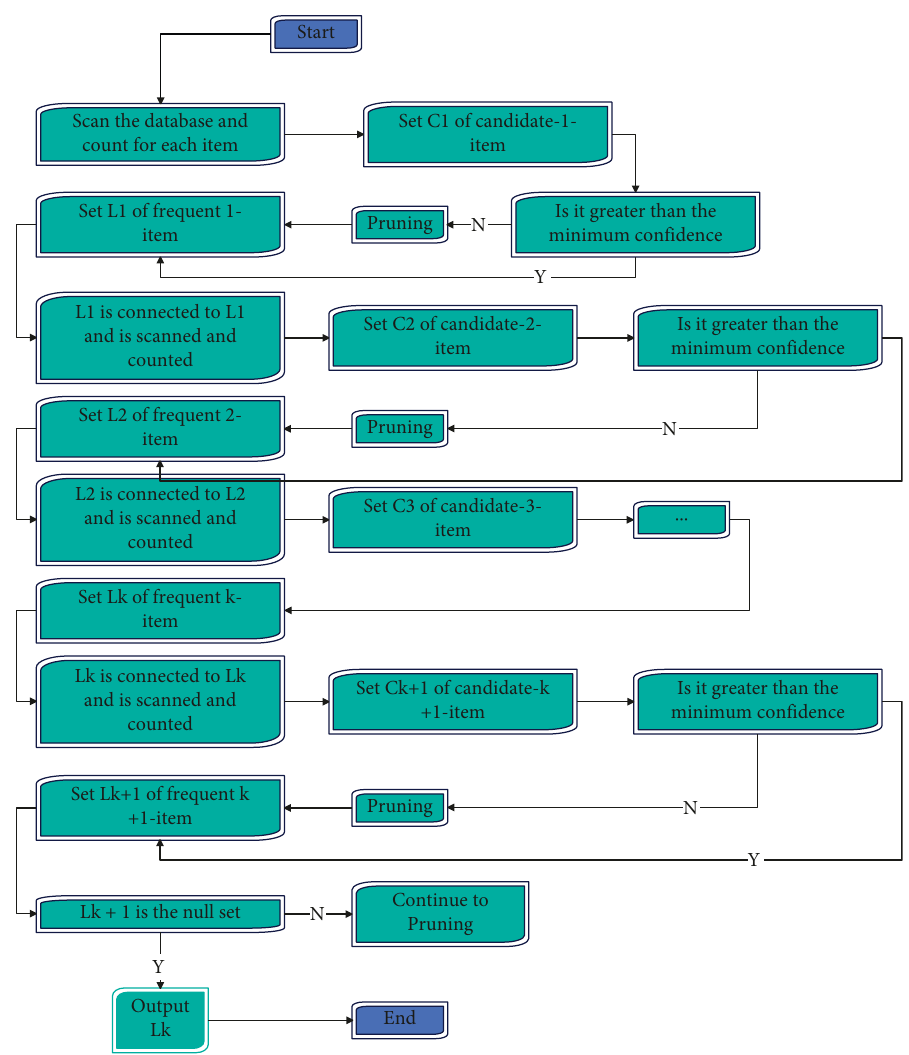
Figure 6: Intelligent data process of tourism management engineering